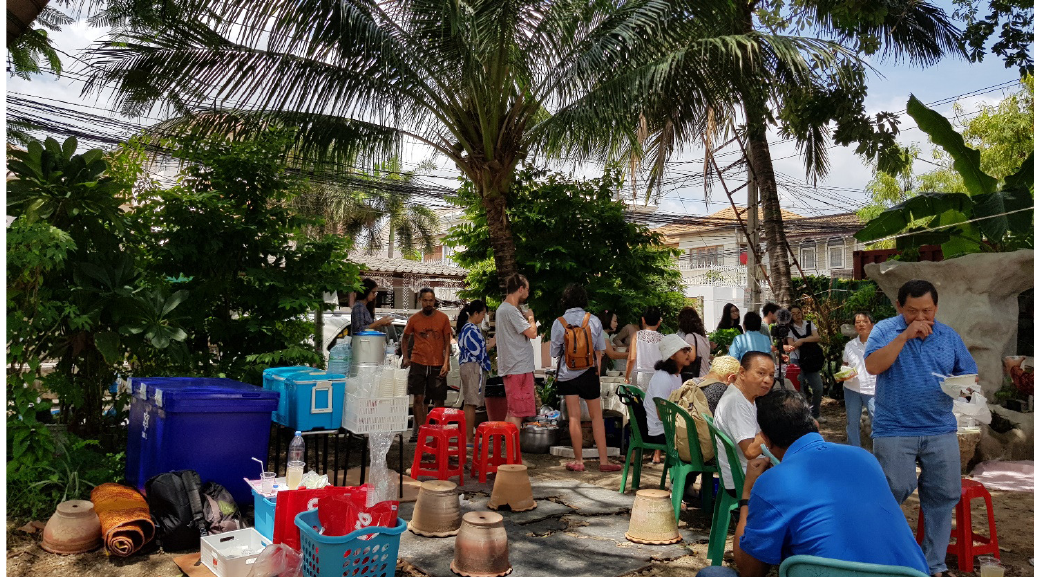
Figure 8. Lunch and ceremony inaugurating Michäel Harpin’s sculpture, visible on the right (August 2018). Photo courtesy of Hong